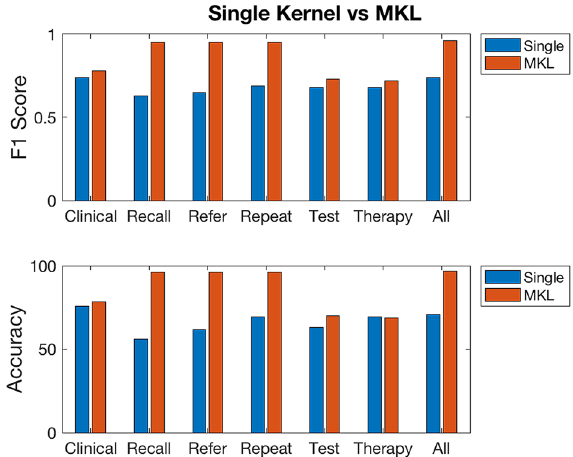
Figure 8. Best F1-score and accuracy achieved from classification with a single kernel vs MKL.